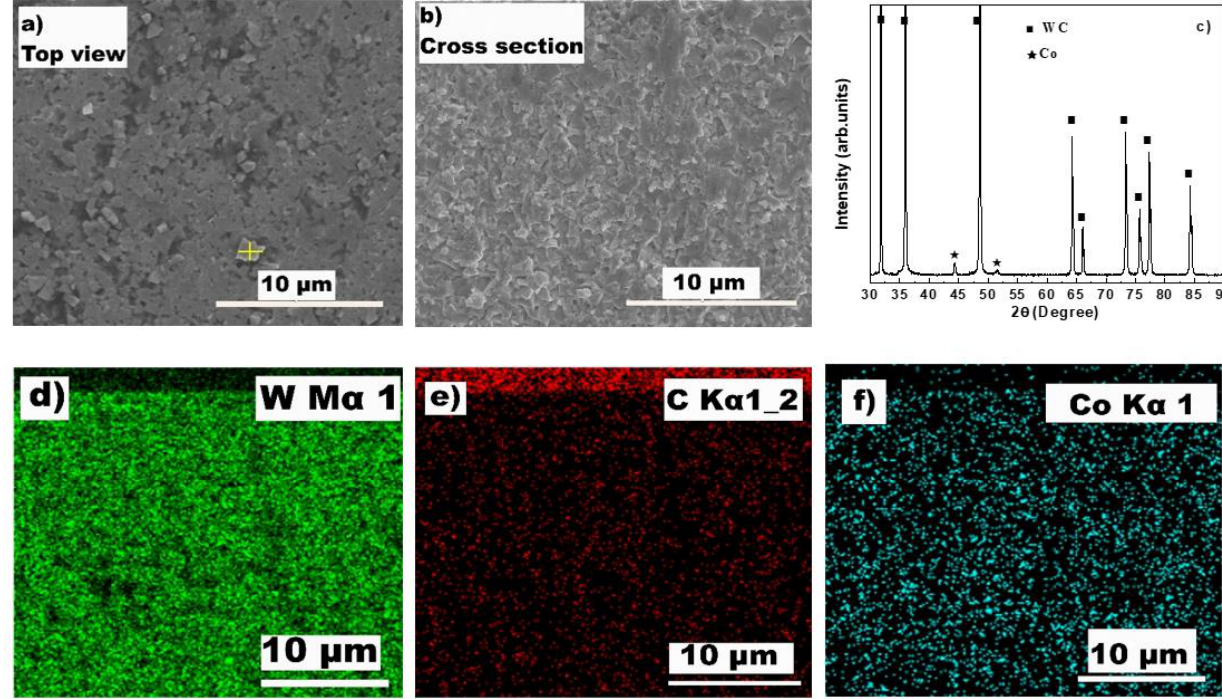
Figure 5. ( a , b ) Surface and cross-sectional FESEM images, ( c ) XRD pattern, and ( d – f ) EDS mappings of HFCVD-B5# spec- imen.